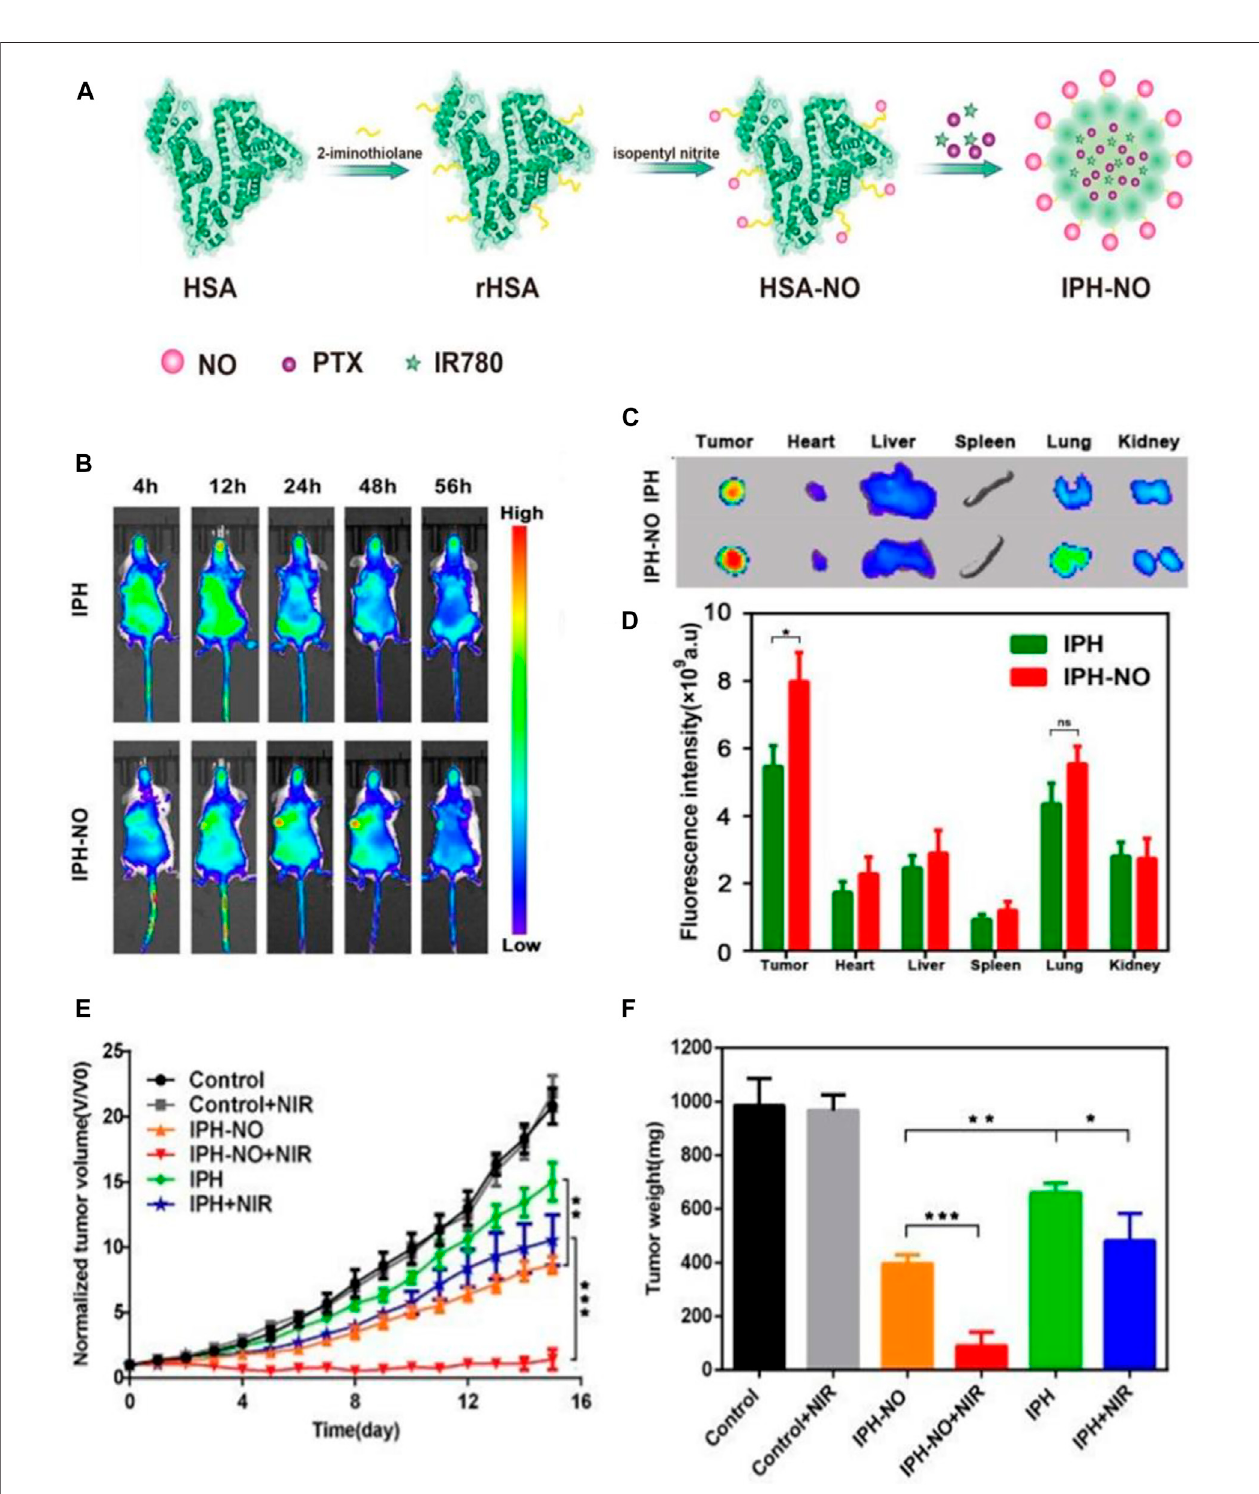
FIGURE4 | Gas therapy-based cancer theranostics. (A) Schematic illustration of thesynthesis procedure ofIPH – NO. (B) The whole-body fl uorescence images of 4T1 tumor-bearing mice at different time points after i.v. administration of IPH or IPH-NO. (C) Fluorescence images of the excised tumors and major organs from indicated mice at 56 h post-injection. (D) Quanti fi cation of fl uorescence signals of the isolated organs and tumors. (E) Tumor growth curves in mice from different treatmentgroups. (F) Weightoftheexcisedtumorsindifferenttreatmentgroupsatday 15.* p < 0.05,** p < 0.01,*** p < 0.001.ReproducedwithpermissionfromXu et al. (2019). Copyright 2019, Royal Society of Chemistry.